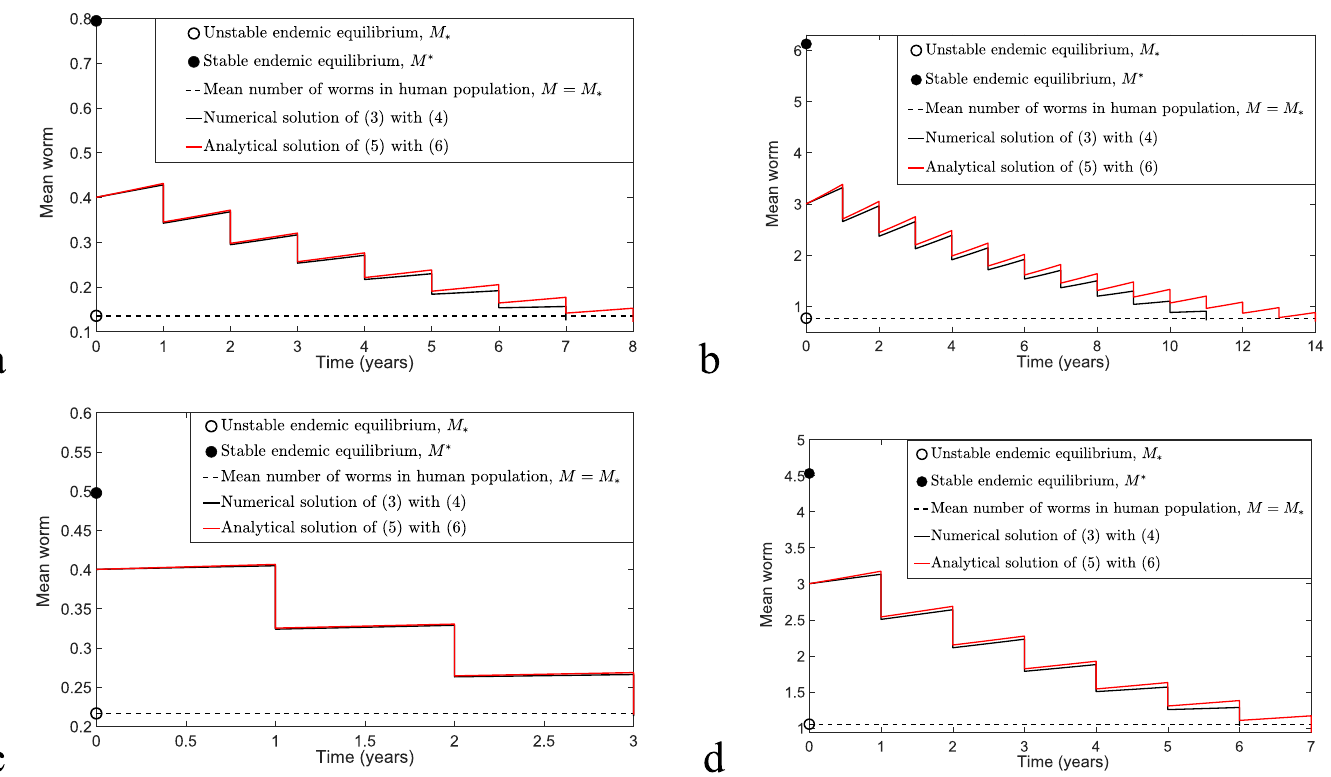
Fig 5. The comparison of solutions (5) and (6) and numerical solutions of model (3) and (4) by considering the implementation of annual MDA with � = 0.4 and ω = 0.5 and varying k and R 0 values. (a) R 0 = 2, k = 0.05, n > 7.29 and MSE = 0.6333 × 10 − 4 . (b) R 0 = 2, k = 0.5, n > 13.14 and MSE = 0.0156. (c) R 0 = 1.8, k = 0.05, n > 2.96 and MSE = 0.2106 × 10 − 5 . (d) R 0 = 1.8, k = 0.5, n > 6.29 and MSE = 0.2264 × 10 − 2